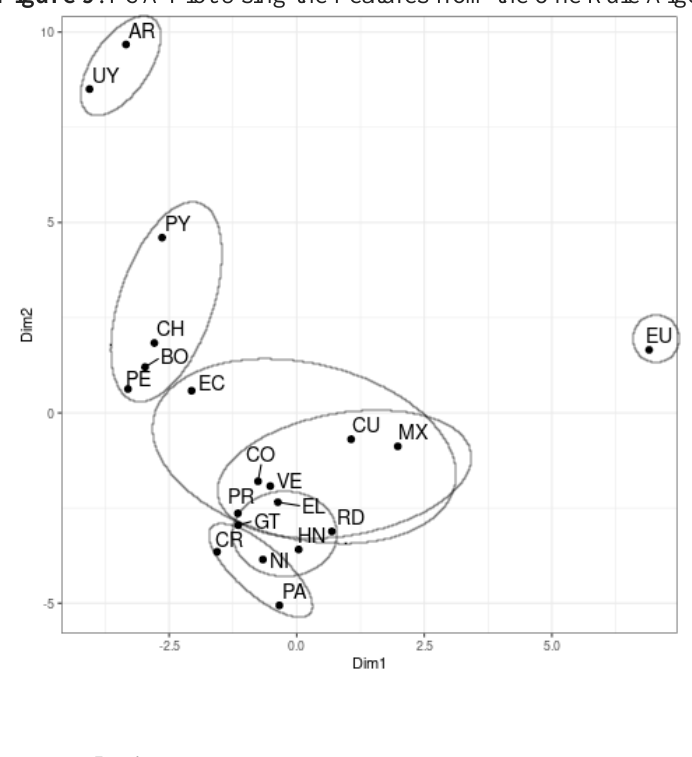
Figure 9 . PCA Plot Using the Features from the One Rule